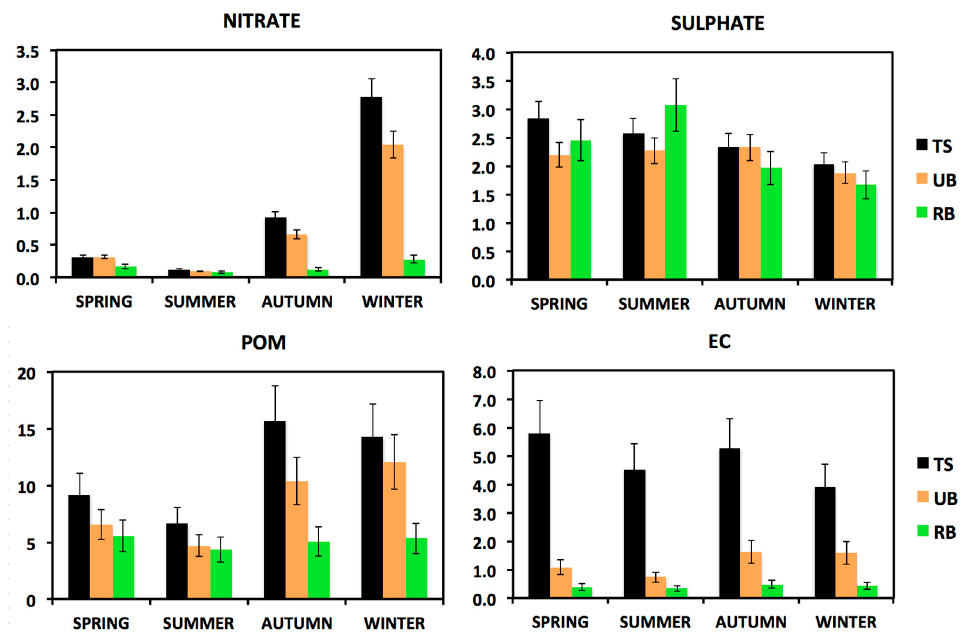
Figure 3. Seasonal averages of POM, EC, nitrate and sulphate in the TS, UB and RB sampling sites.